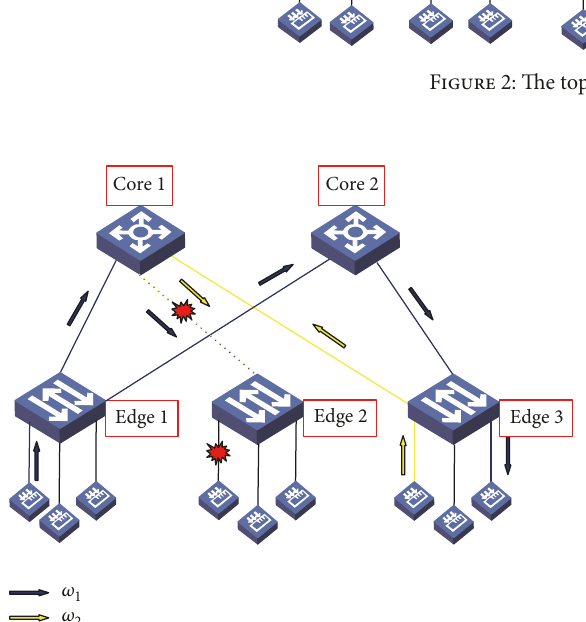
Figure 3: The cause of multicast